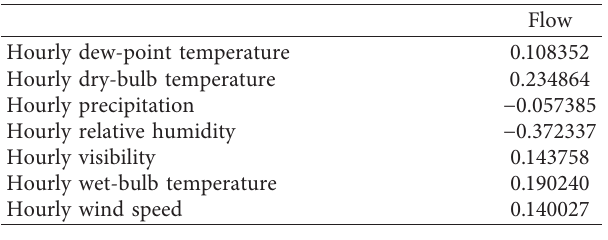
Figure 2: Relation between one-hot coding and embedding. Table 3: PCC of weather parameters and traffic